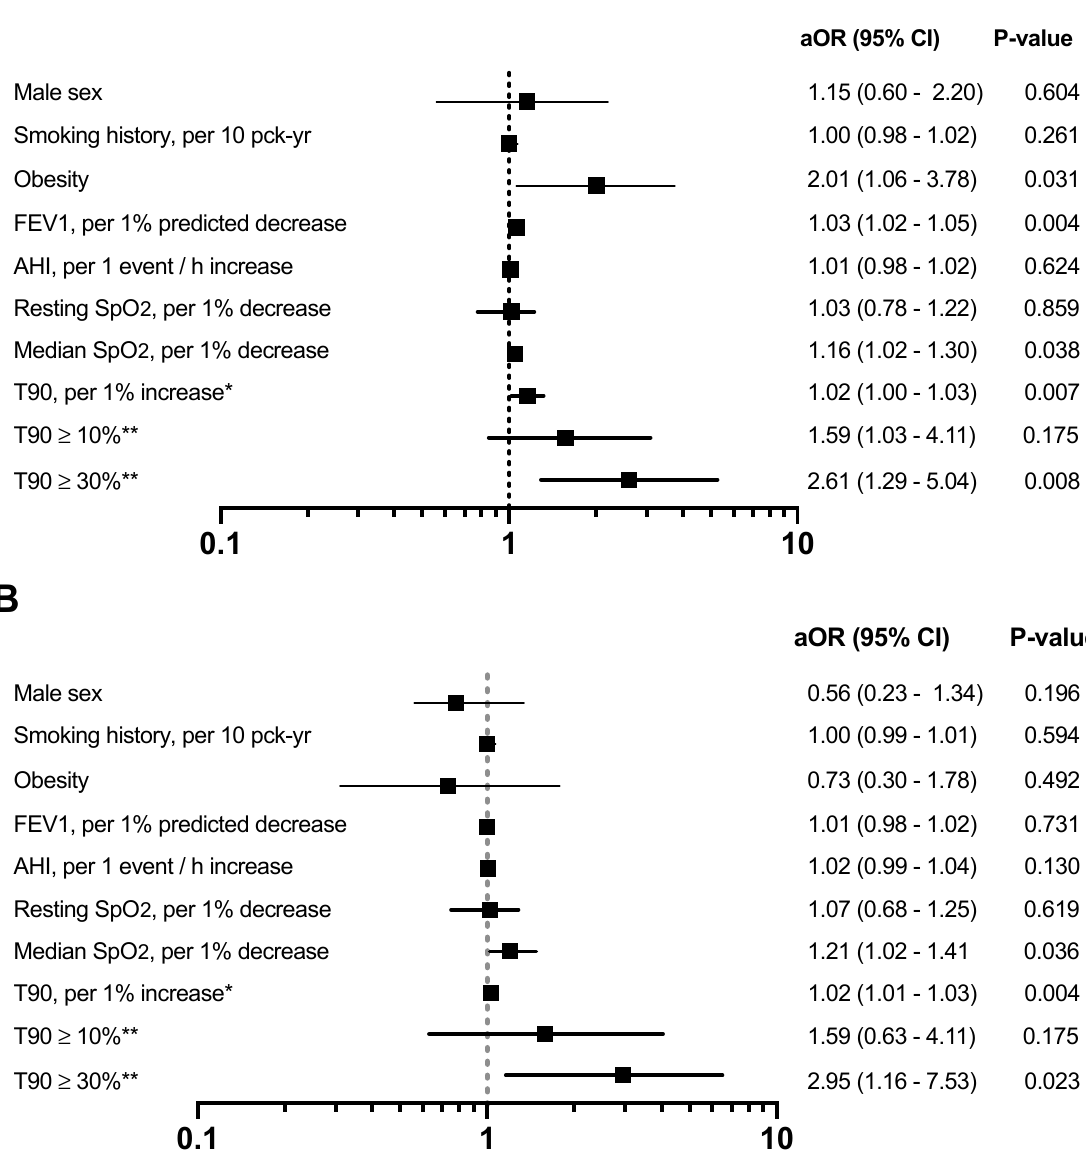
Figure 3. Forest plots of risk factors associated with pulmonary artery enlargement (PAE) as defined by the main pulmonary artery diameters ( A ) and as defined by PA:Ao ratio ( B ). Variables in the multivariate regression model included: age, gender, smoking status (current vs. ex-smoker), smoking history, obesity, FEV 1 % predicted, apnoea–hypopnoea index, resting O 2 saturation, median O 2 saturation and centre site. Abbreviations: aOR = adjusted odds ratio; CI = confidence interval, FEV 1 = forced expiratory volume in one second, AHI = apnoea–hypopnoea index; T90 = percentage of sleep recording time with oxygen saturation < 90%. * OR estimates in the fully adjusted model instead of median O 2 saturation. ** OR estimates in the fully adjusted model instead of median O 2 saturation and T90.